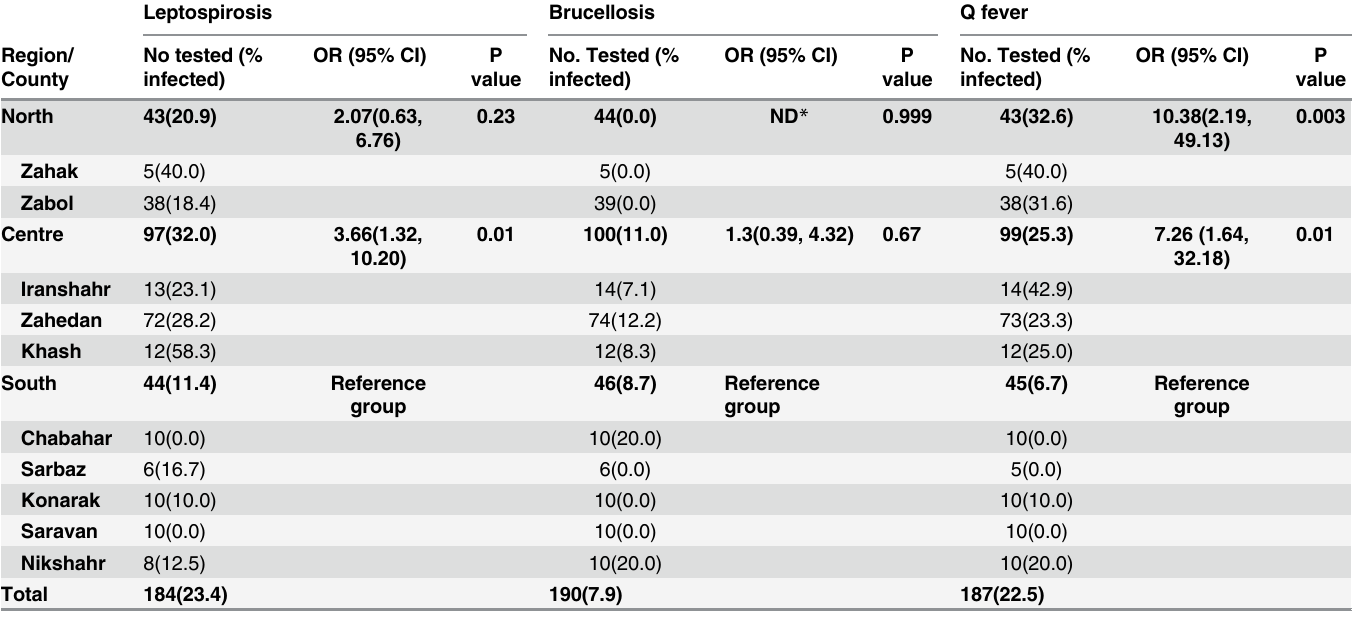
Table 2. Seroprevalence of Q fever, brucellosis and leptospirosis among butchers and slaughter workers in Sistan va Baluchestan province according to region and